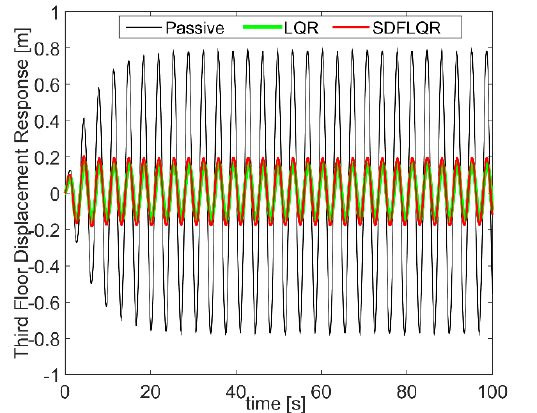
Figure 4. Controlled and uncontrolled displacemet time responses of the third floor of offshore steel jacket platform.